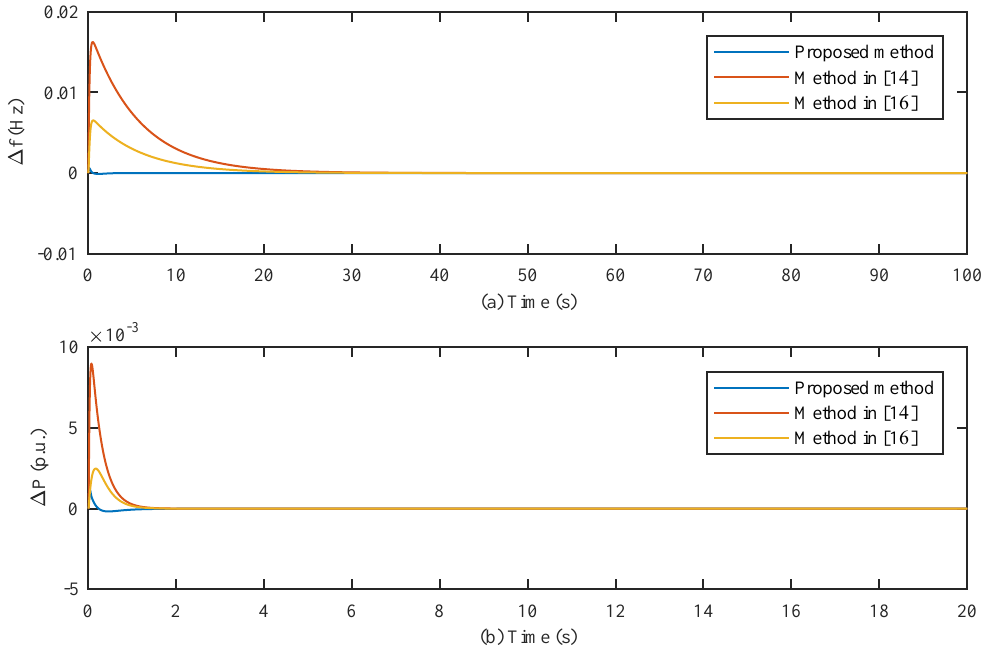
Figure 11. System transient response. ( a ) Microgrid frequency deviation. ( b ) Total power deviation.